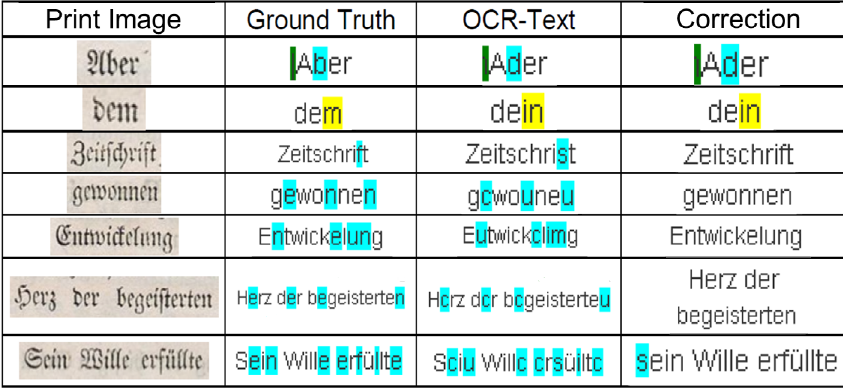
Table 2 OCR post correction